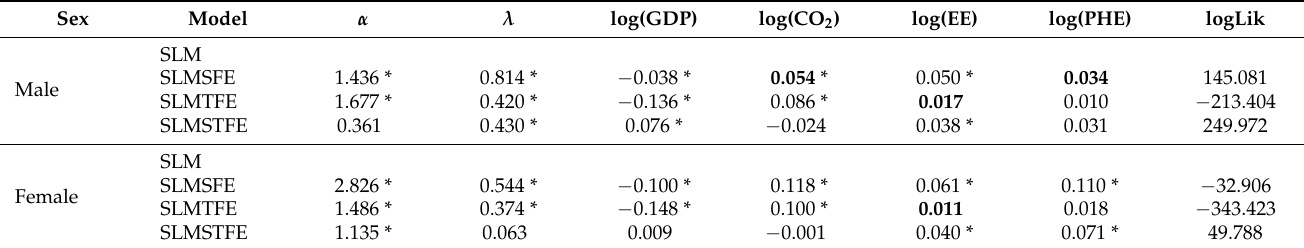
Table 2. Model fittings using the splm function in R by sex.